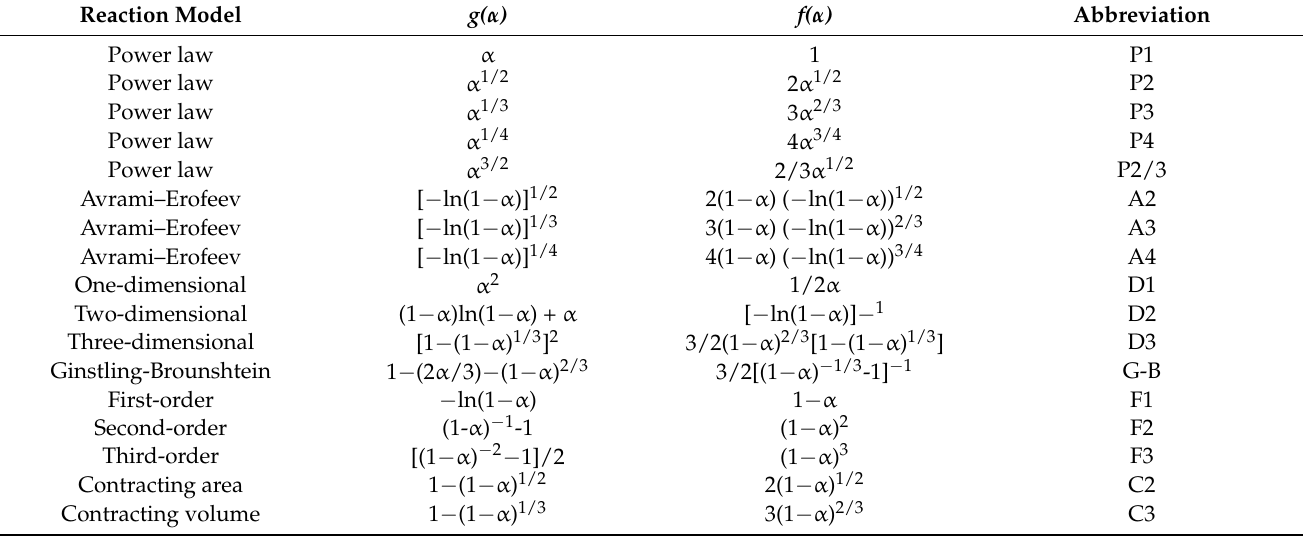
Table 2. Thermal decomposition reaction models of 17 common solid substances.